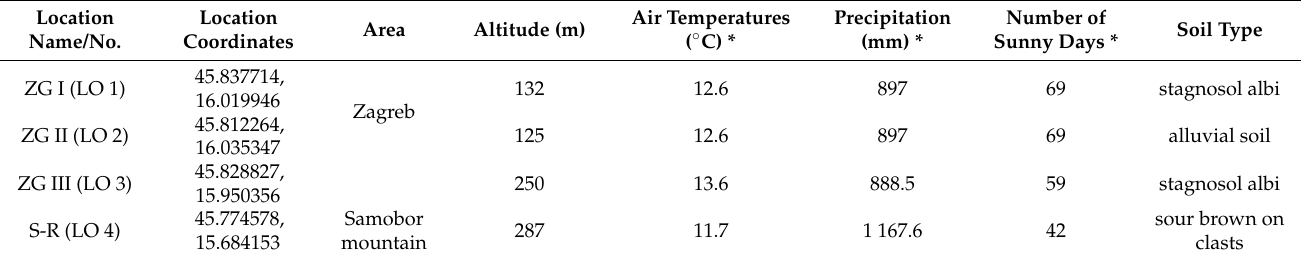
Table 1. Location geographical coordinates, meteorological data [20] and soil type [21] of collected wild garlic populations within the continental Croatia.